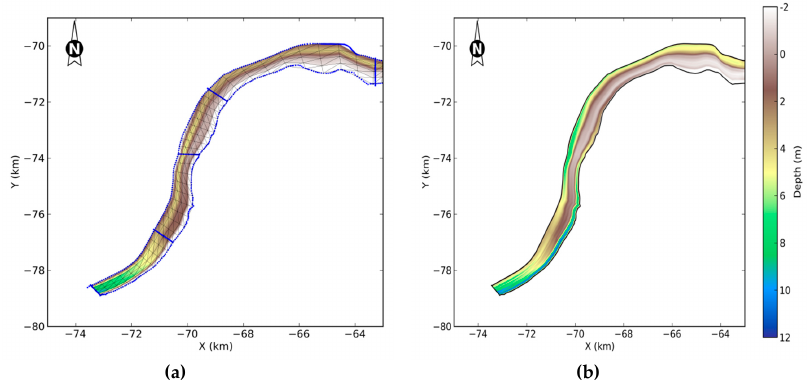
Figure A1. Extraction of 2D bathymetries from cross-sectional data in the upper Tagus estuary for (NL,NPS) = (5,10) ( a ) and (NL,NPS) = (20,50) ( b ). The blue dots indicate the margins and the 5 sections where cross-sectional data are available.